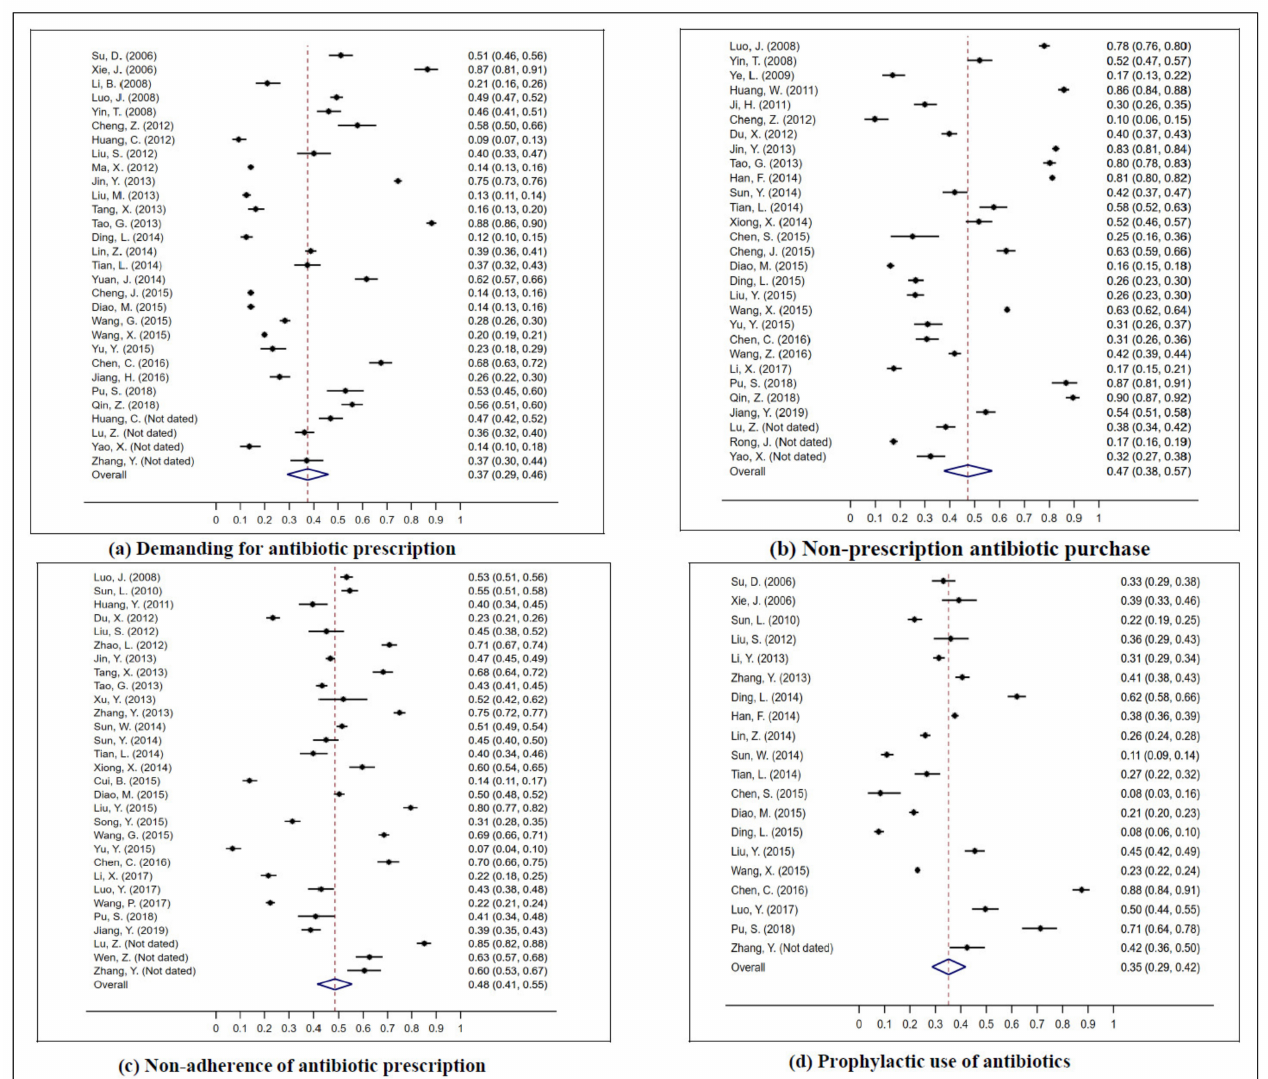
Figure 3. Meta-analysis of the pooled proportion of the general population’s irrational use behaviors regarding antibiotics. ( a ) Demanding for antibiotic prescription. ( b ) Non-prescription antibiotic purchase. ( c ) Non-adherence of antibiotic prescription. ( d ) Prophylactic use of